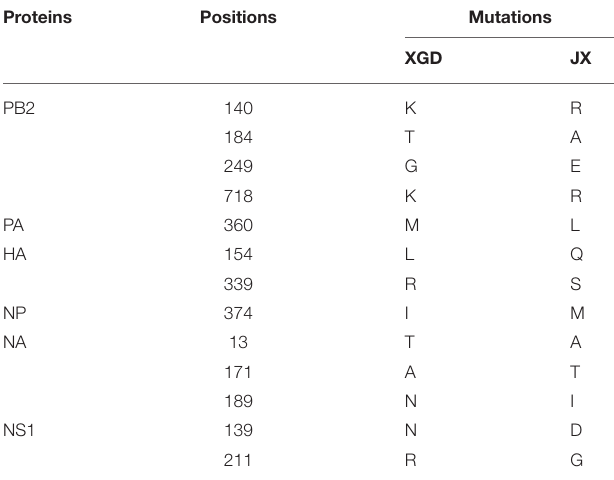
TABLE 1 | Amino acid variations in the JX and XGD strains of H5N6.